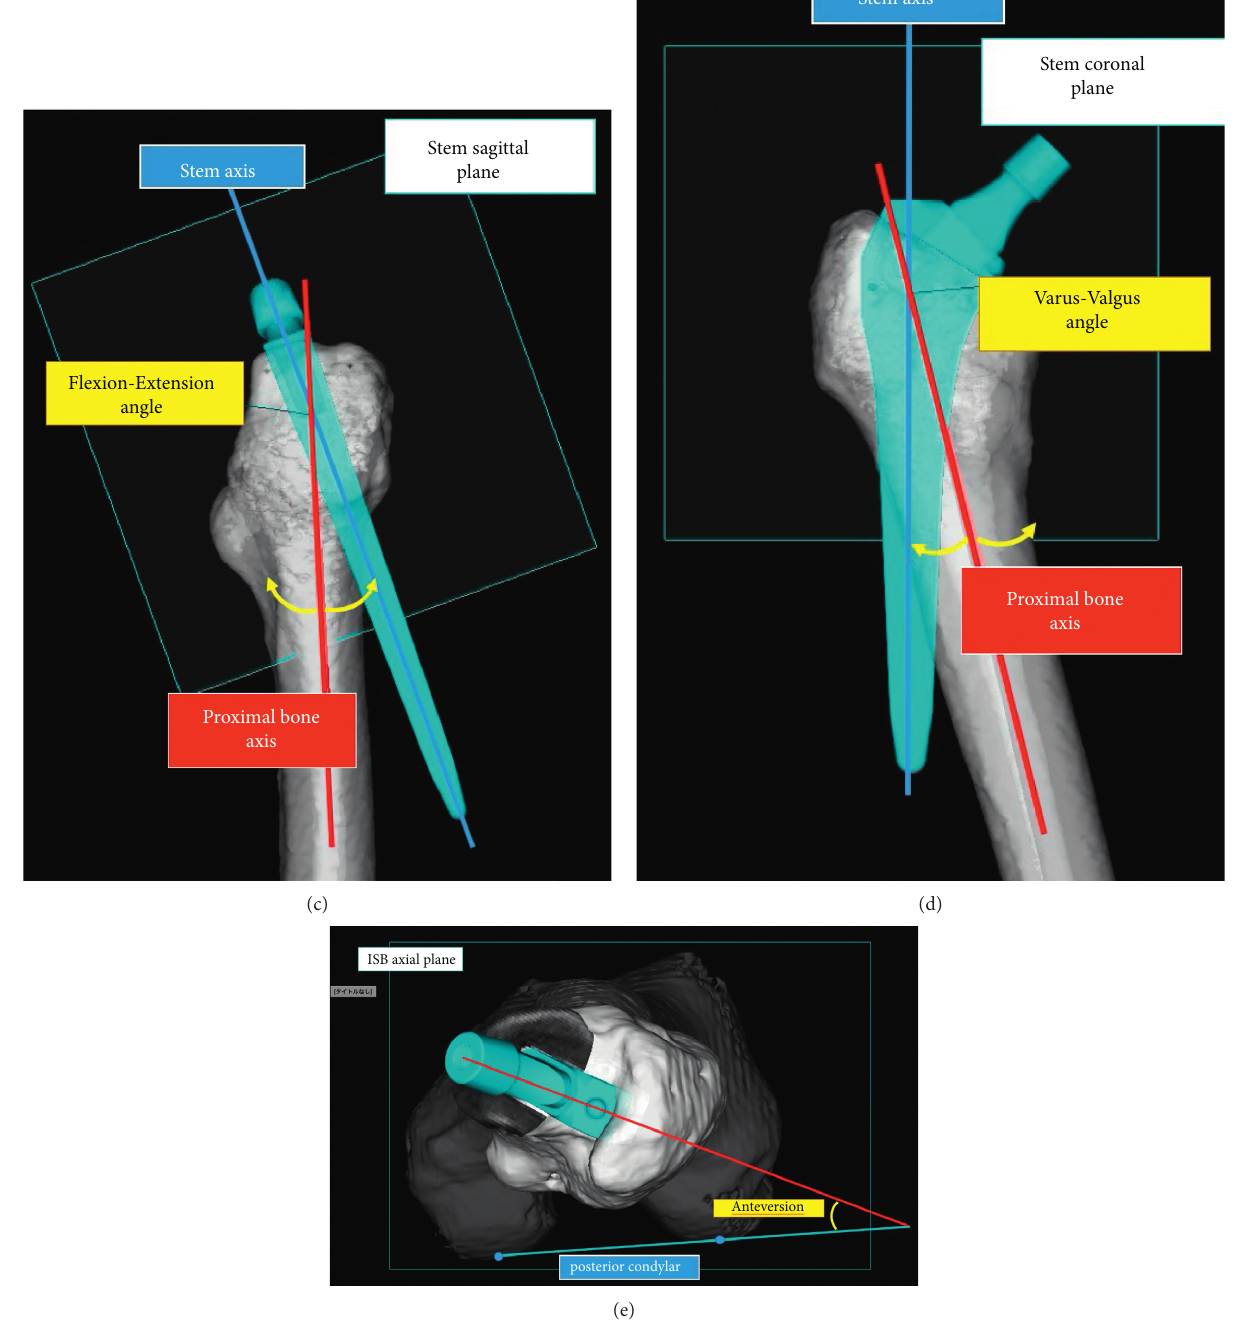
Figure 4: Alignment of components. The radiographic inclination (RI) (a) and radiographic anteversion (RA) (b) of the cup measured according to the acetabular coordinate system. The alignment of the stem measured according to femoral coordinate systems (c), (d), proximal bone axis and the femoral component on the sagittal plane (Figure 4). The definition of three-dimensional femoral coordinate systems was as follows. X -axis: the line perpendicular to the Z -axis and passing through the origin on the plane created by the three